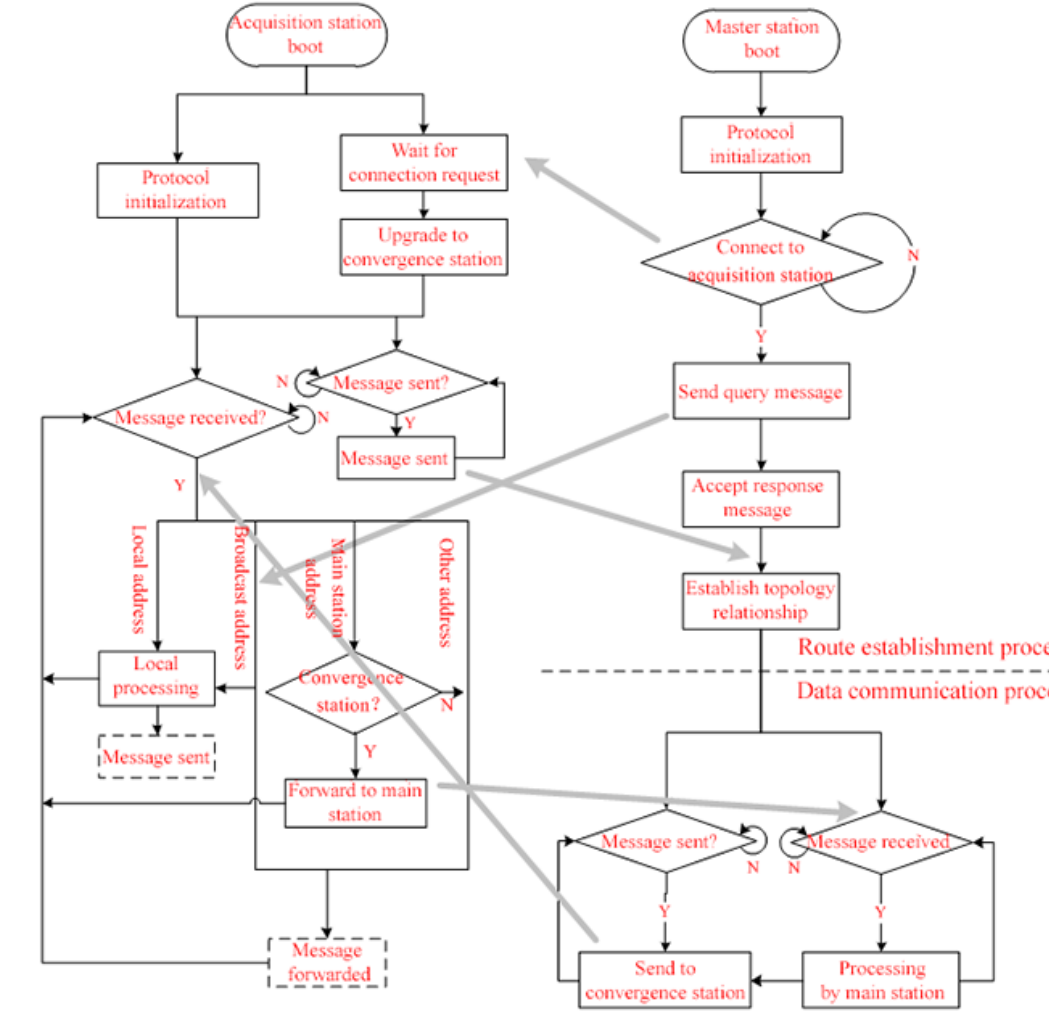
Figure 7. Communication and interaction process of the wireless